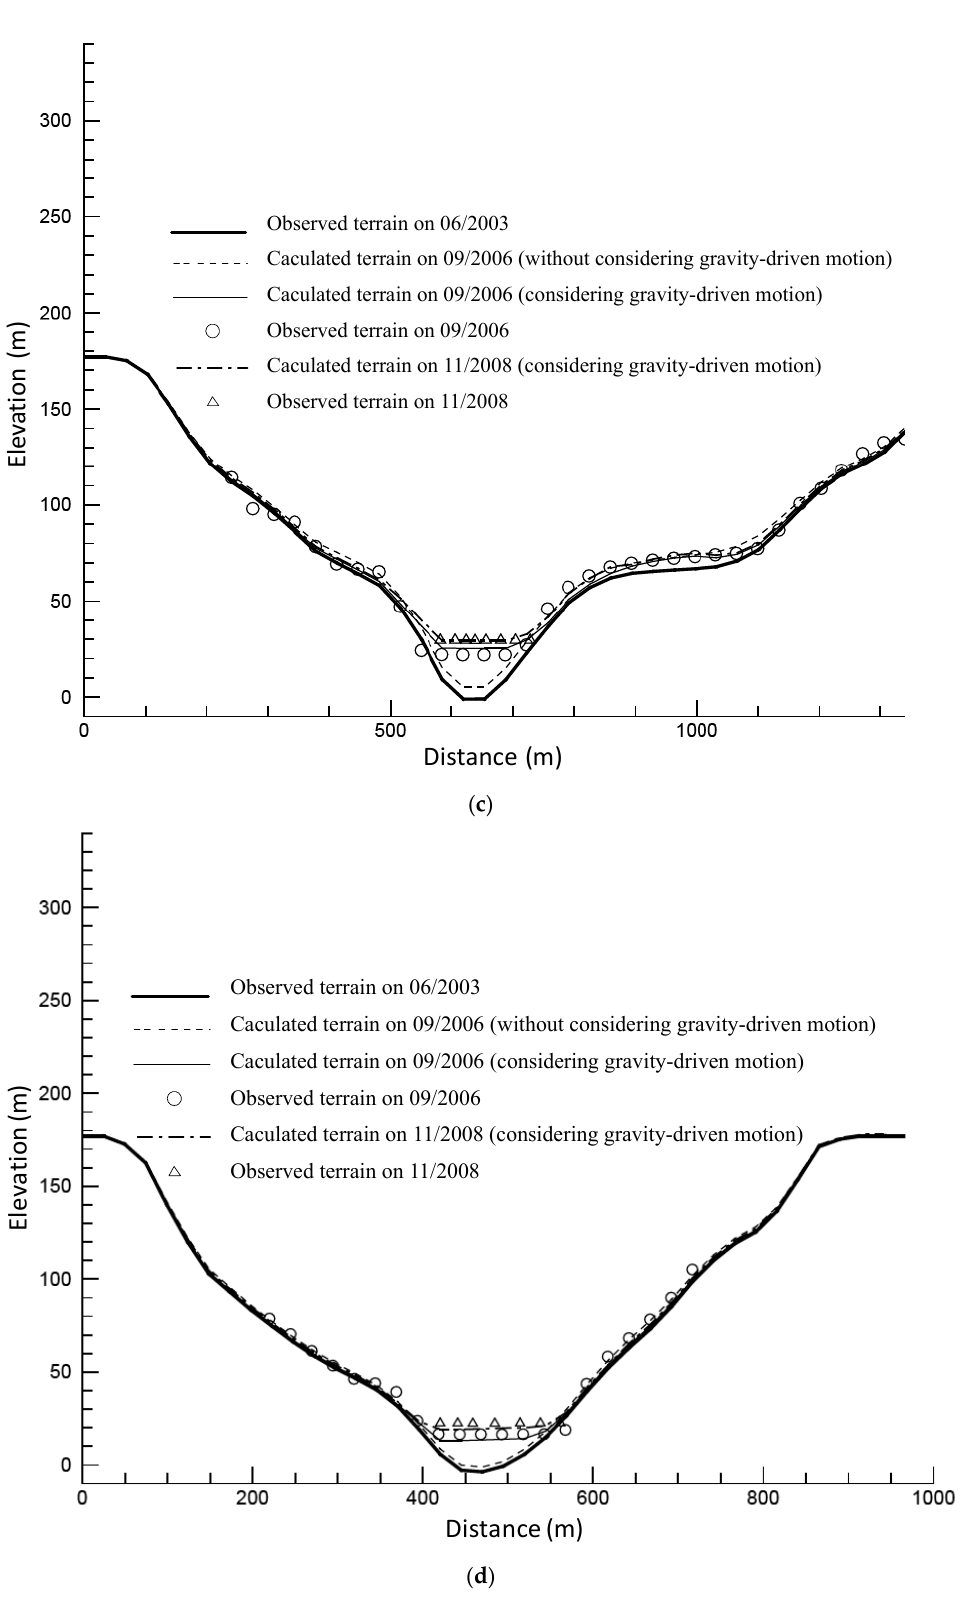
Figure 12. Comparisons of the sediment distributions on a typical cross-section between the observations and simulated results. ( a ) on section S30+1; ( b ) on section S32; ( c ) on section S34; ( d ) on section